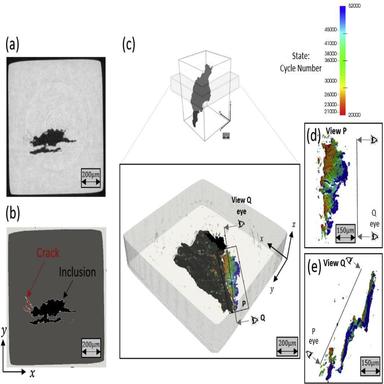
(a) Cross-section from m-CT reconstruction juxtaposed with (b) results of segmentation of the different phases: matrix, inclusion, and crack. (c) Specimen with inset showing the crack growing from the inclusion between 20k and 52k cycles. (d) View of the crack along plane P (as defined in c), displaying crack growth relative to the cycle number. (e) View of the crack from vantage point Q (as defined in c), showing a bridge in the crack structure.